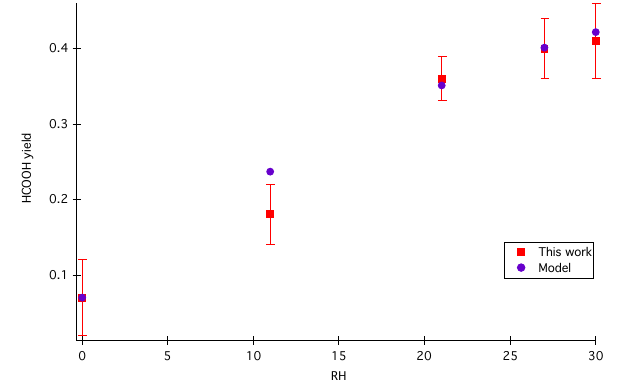
Fig. 7. Modelled HC(O)OH yields as a function of RH%. Figure 8: The annual mean surface formic acid derived from the base case model run.